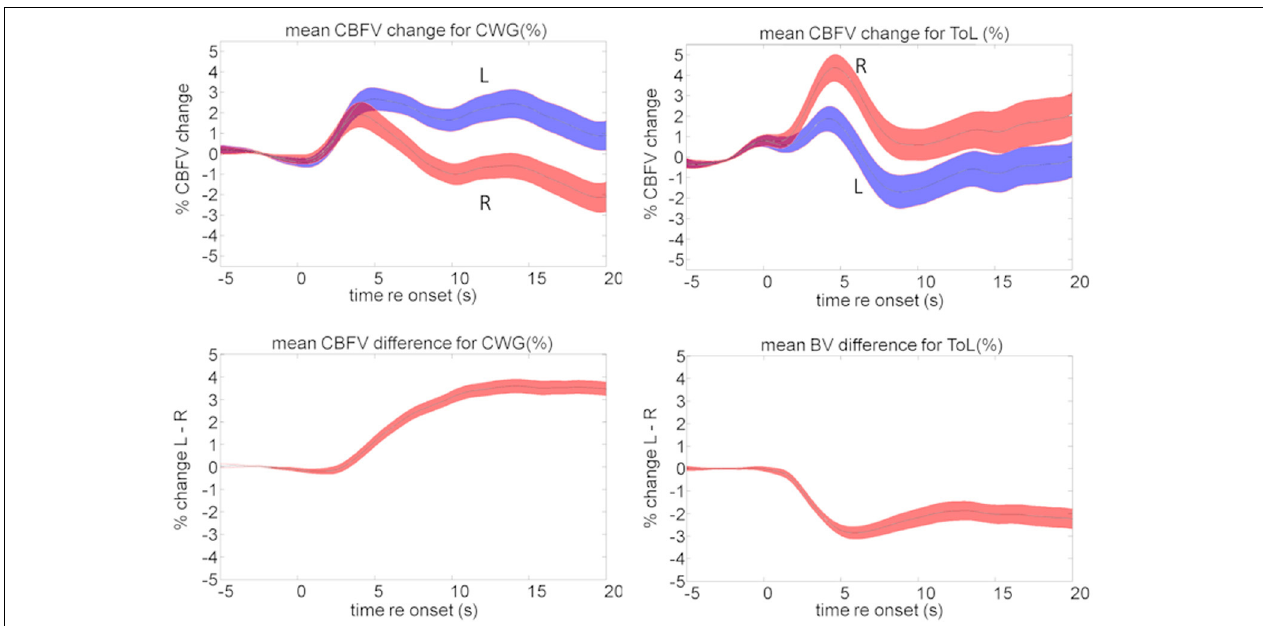
FIGURE 8 | Mean cerebral blood flow changes (top) and lateralization pattern (bottom) for the cued word generation (CWG, left) and Tower of London (ToL, right) task. The shaded